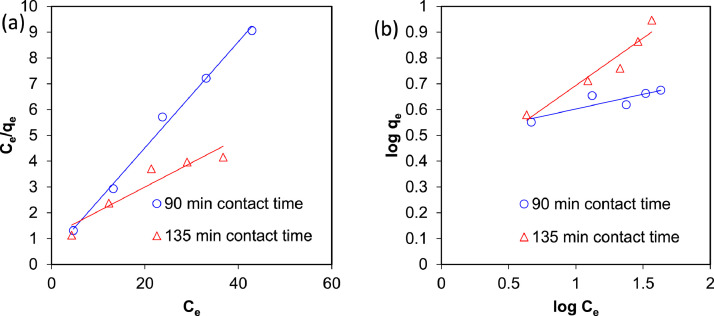
Adsorption isotherms for AO10 removal on BiVO4/zeolite composite of a) Langmuir and b) Freundlich.